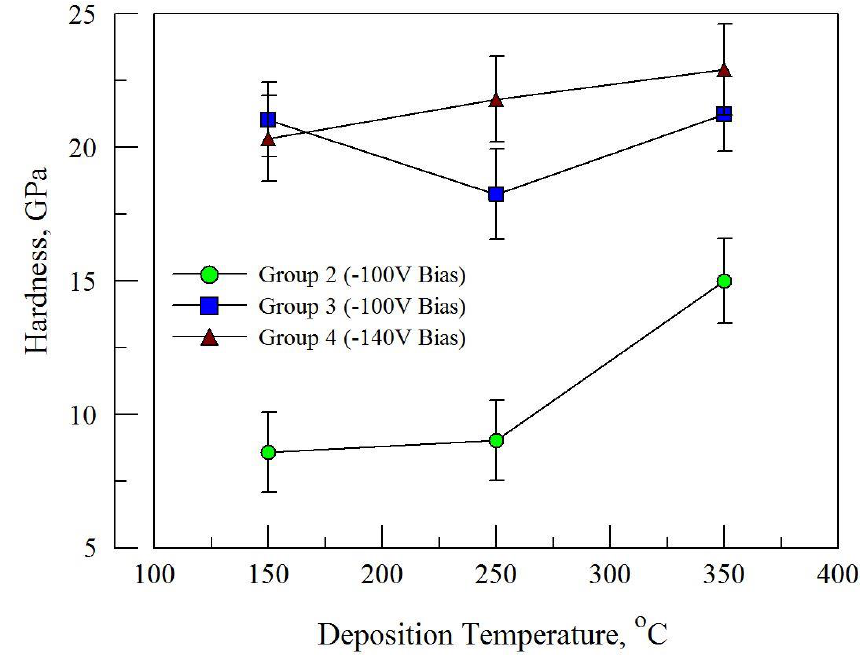
Figure 7. Nano-indentation hardness for selected films. The standard deviation in the measured hardness values is shown. The higher hardness levels in groups 3 and 4 corresponds to higher nitrogen levels and improved film density.